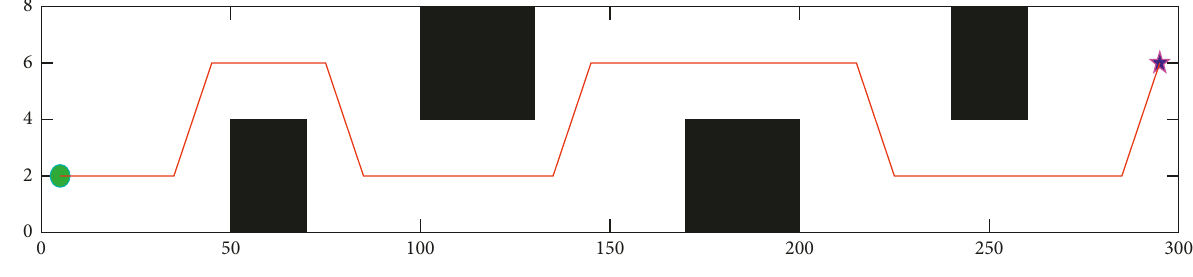
Figure 11: Planning path integrating artificial potential field